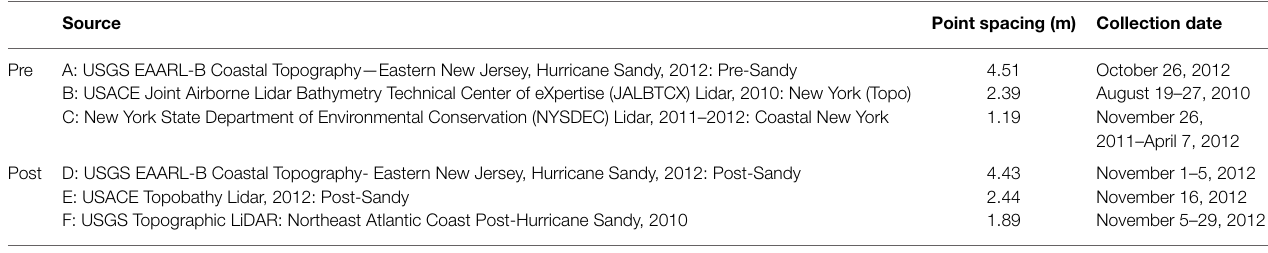
TABLE 2 | Average point spacing and collection date of pre- and post-Sandy LiDAR ground elevation surveys.